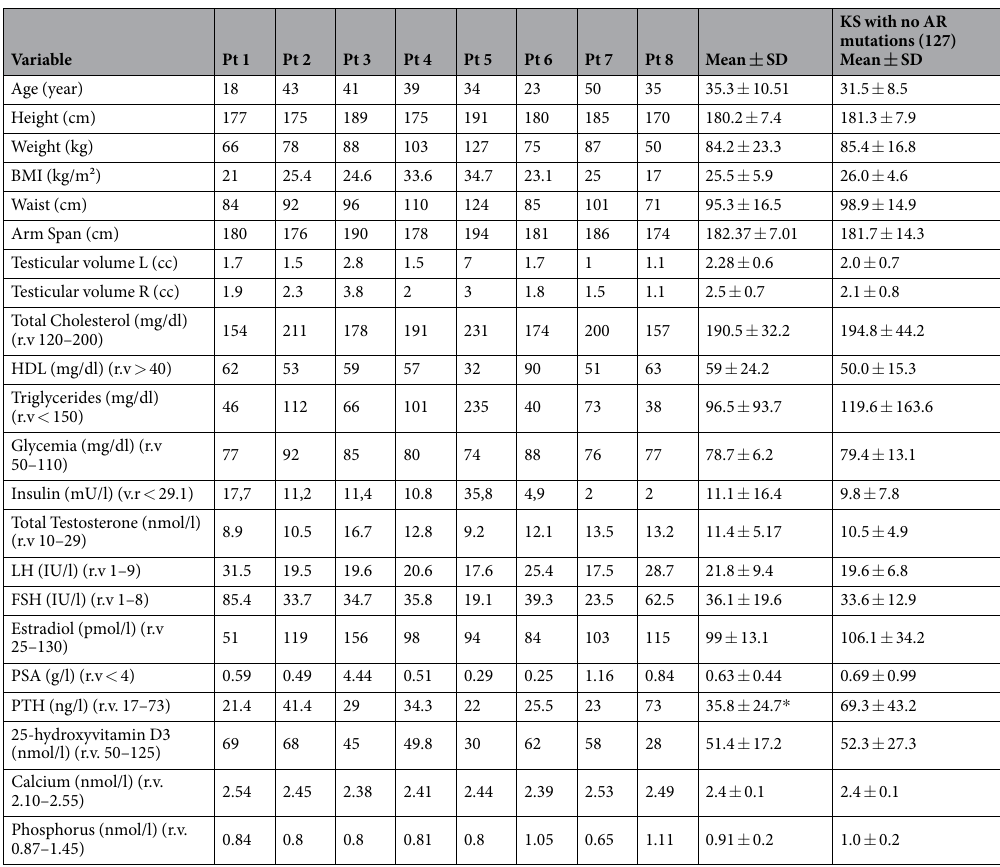
Table 1. Clinical characteristics observed in 8 AR mutated and in 127 non mutated KS